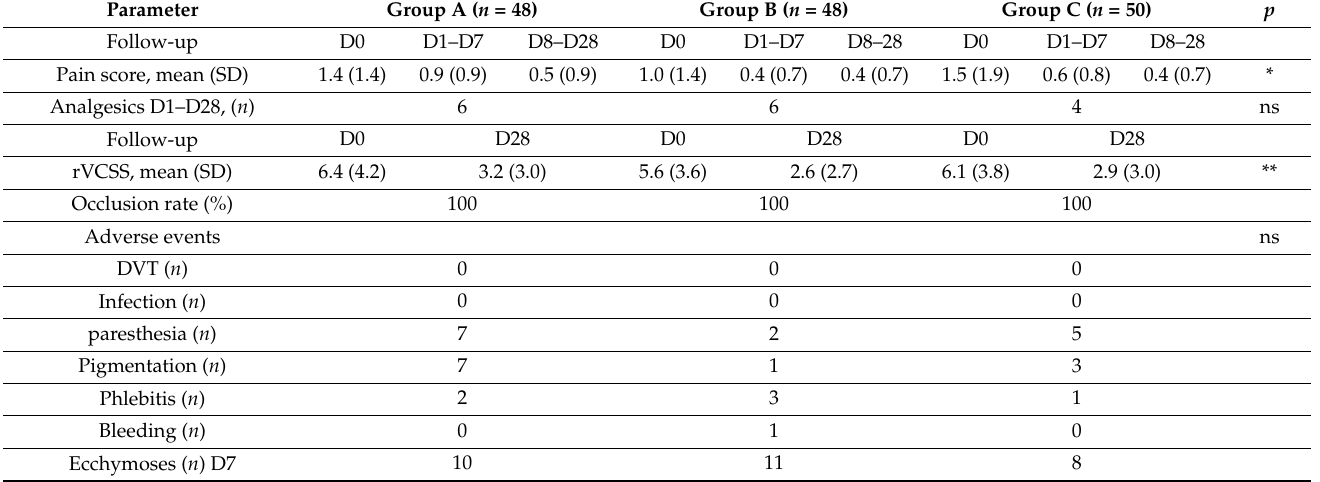
Table 2. Clinical results after EVLA ( n = number of participants, D0 = day of intervention, D1–D7 = follow-up of the first week, D8–D28 = follow-up of week 2–4, p = p -value, analgesics = number of patients who took analgesics, rVCSS = venous clinical severity score, occlusion = occlusion rate, normal activity = return to normal activity, work = return to work, satisfaction = satisfied with method (score 1–4), repeat = would choose method again (score